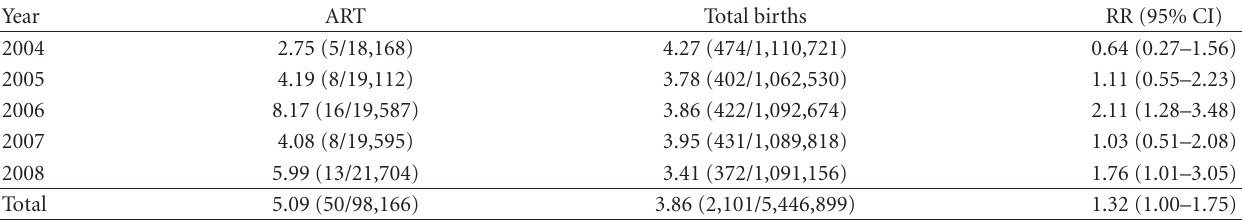
Table 5: Crude early neonatal mortality rate as to birth defects (per 10,000 live